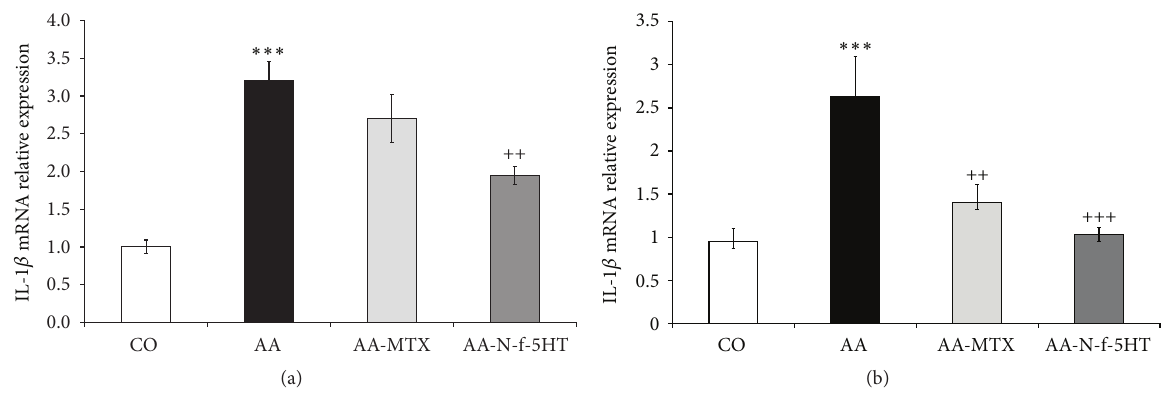
Figure 3: Relative changes of IL-1 𝛽 mRNA expression normalized to 𝛽 -actin mRNA in the liver (a) and in the spleen (b). Control was preset at 1. CO, control group; AA, adjuvant arthritis group; AA-N-f-5HT, adjuvant arthritis group given N-feruloylserotonin; AA-MTX, adjuvant arthritis group given methotrexate. The results are given as average ± SEM; 𝑛 = 8 – 10 . The symbols ∗ and + show significant difference: ∗∗∗ 𝑝 < 0.001 versus CO; ++ 𝑝 < 0.01 versus AA; +++ 𝑝 < 0.001 versus